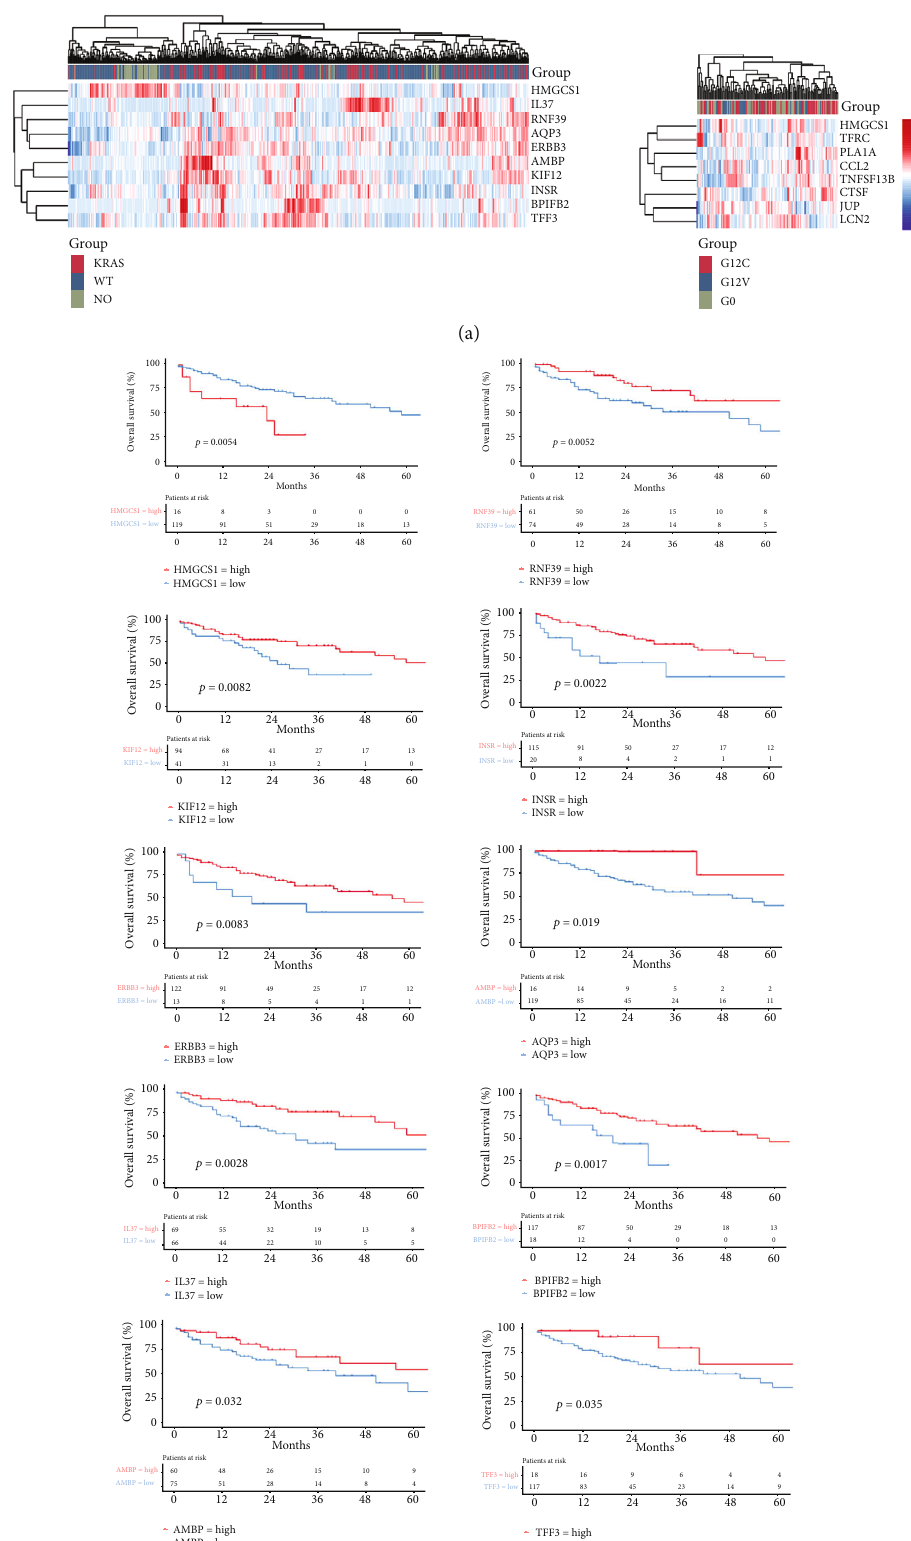
Figure 3: (a) Left: the heatmaps of the survival-related secretory or membrane-associated protein DEGs. Right: the heatmaps of the secretory or membrane-associated protein DEGs among KRAS mutation subgroups. (b) Kaplan-Meier curves of OS about ten genes in LUAD patients with KRAS